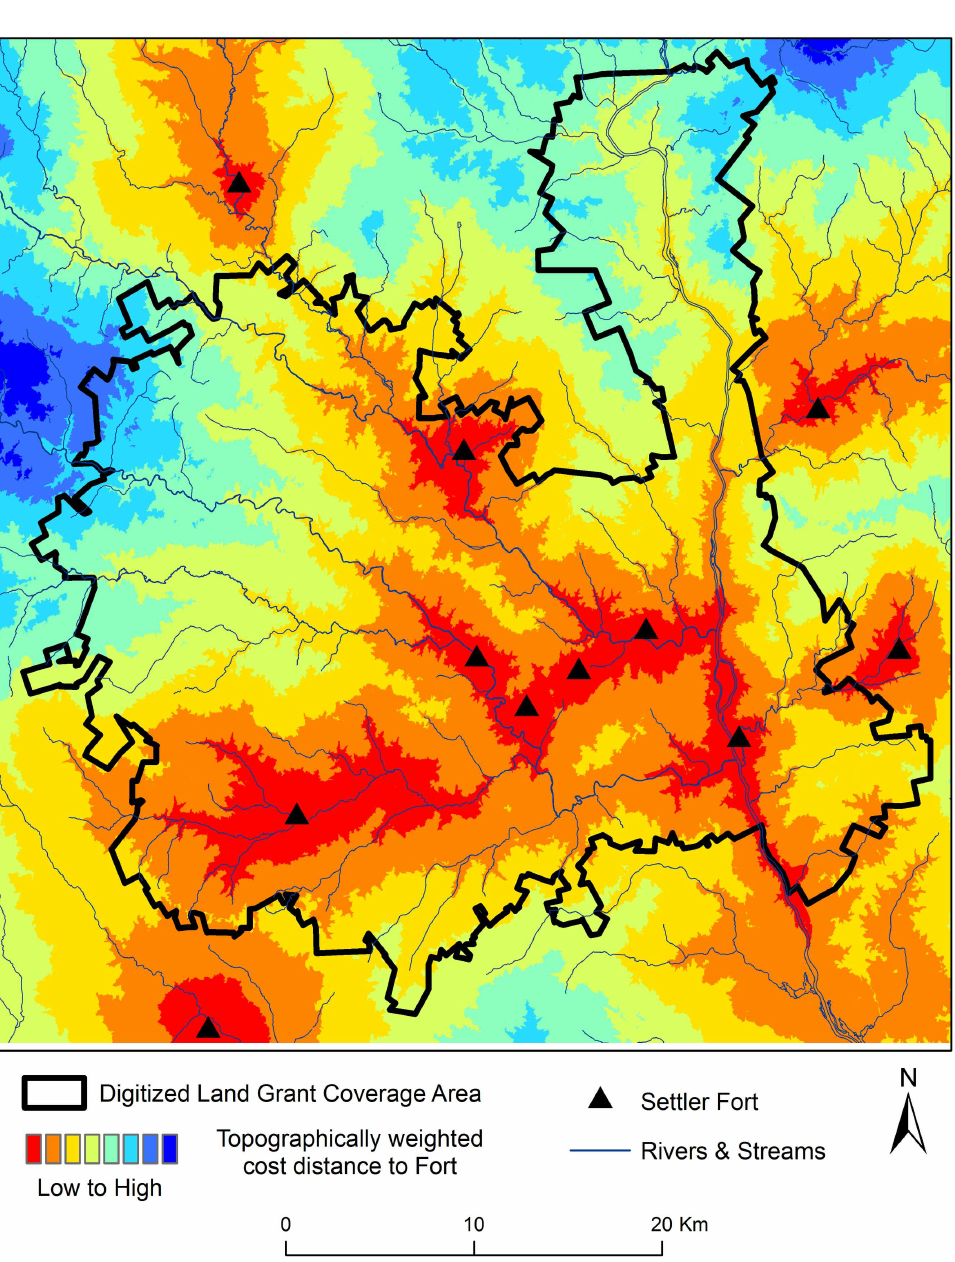
Fig 5. Location of Anglo-Cherokee War era settler forts and topographically weighted cost distance to nearest